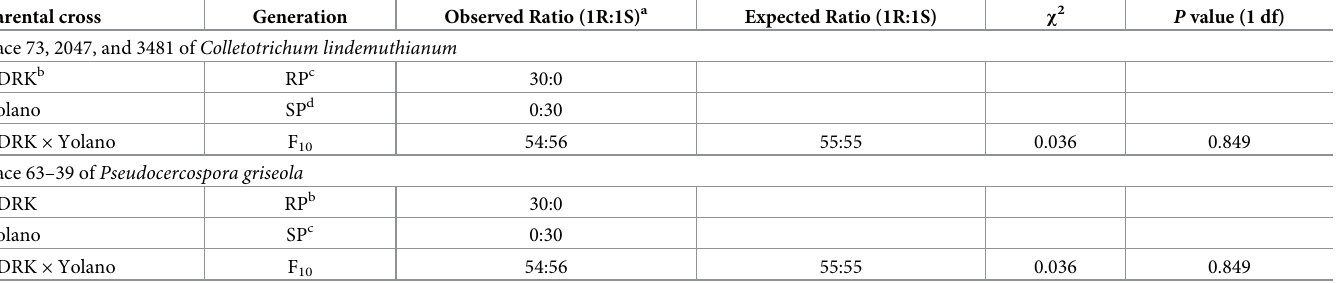
Table 2. Segregation for resistance to races 73, 2047, 3481 of Colletotrichum lindemuthianum and 63–39 of Pseudocercospora griseola in common bean F 10 RIL pop- ulation from the California Dark Red Kidney × Yolano cross. Parental